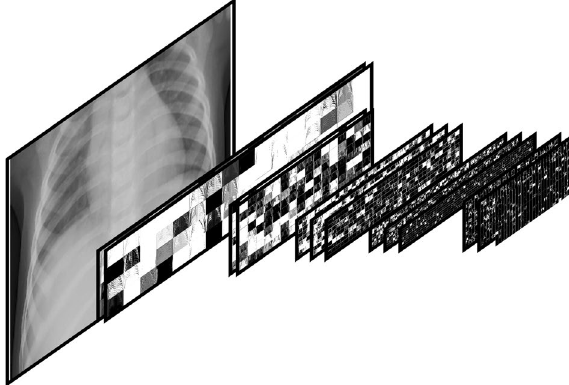
Fig. 8 Filters extracted from the architecture of VGG16 model. There are 64 filters in VGG16 model and they are presented above. Each filter has size 3 by 3 by 3. We code them into three colors by using RGB palette